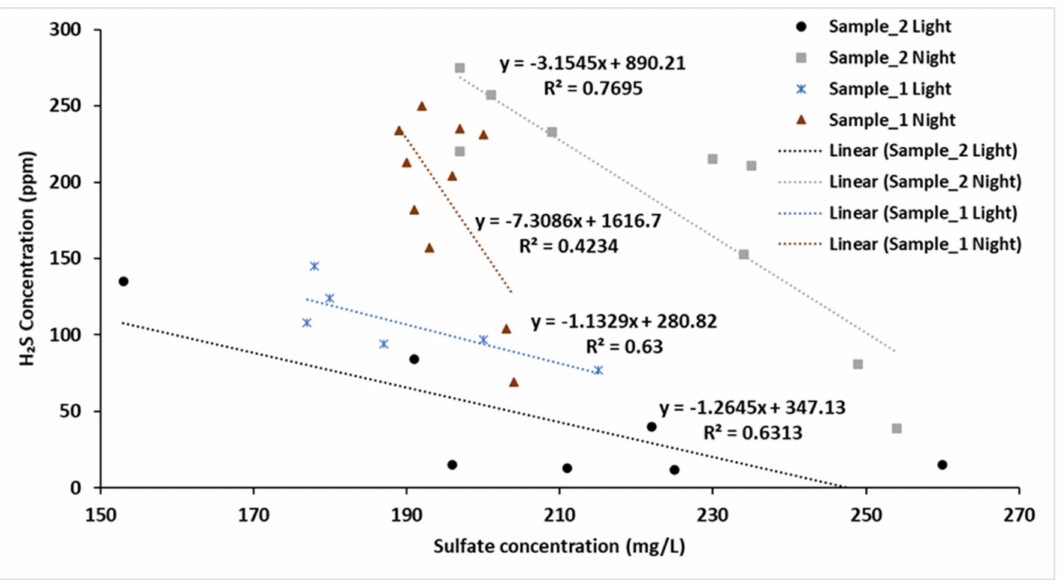
Figure 2. Comparison between H2S concentration and sulfate concentration during the day and night of the first and second sampling